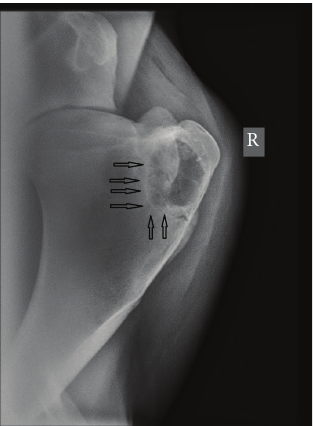
Figure 6: Cranial 45 ∘ medial-caudolateral view of the humerus two weeks after surgery: the radiolucent area shows a sclerotic rim (black